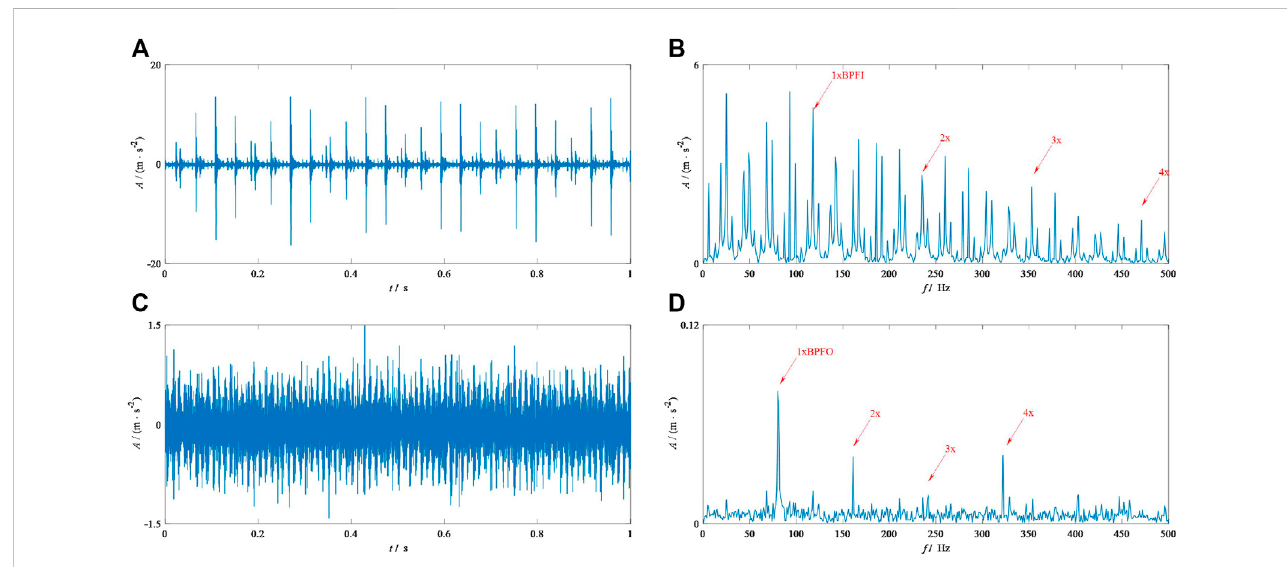
FIGURE 9 Results from ICF-VMD for the MFPT signals: (A) and (B) correspond to the TDW and the corresponding SES of the inner race fault bearing; (C) and (D) correspond to the TDW and the corresponding SES of the outer race fault bearing.